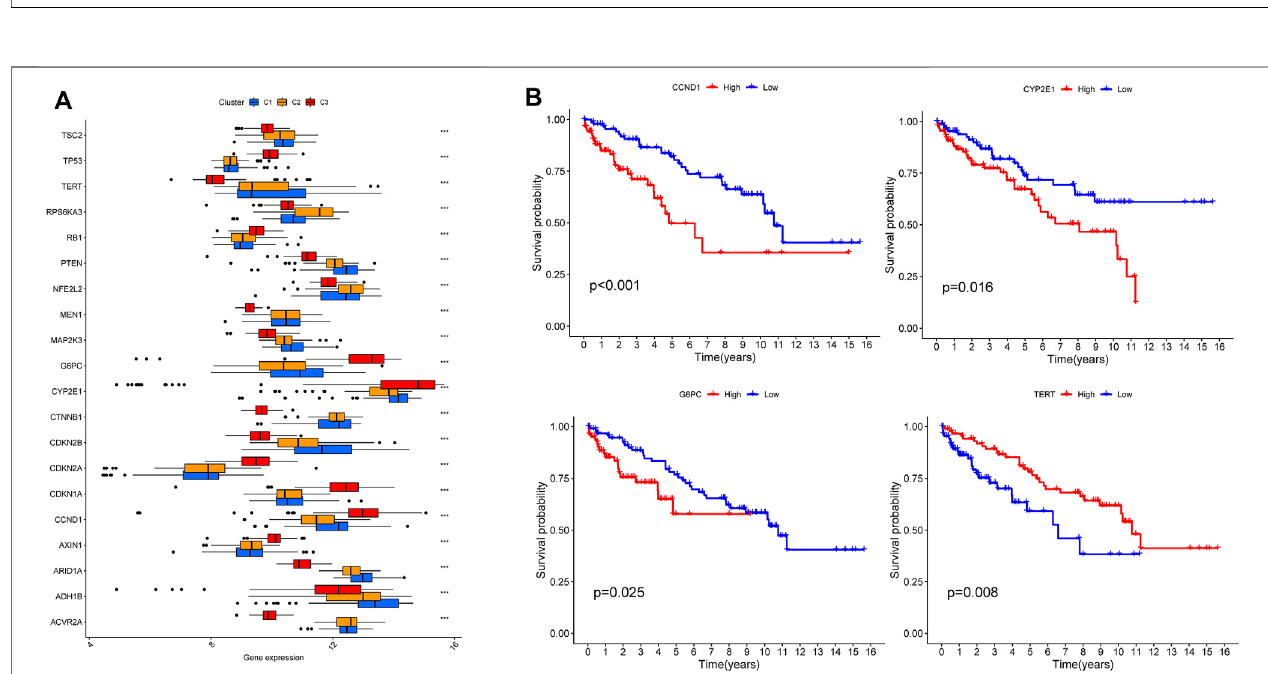
FIGURE 5 | DGCs expression across three HCC clusters and prognostic analysis (A) . Differential expression analysis of 20 DGCs (B) . Kaplan-Meier analysis of CCND1, CYP2E1, G6PC and TERT.